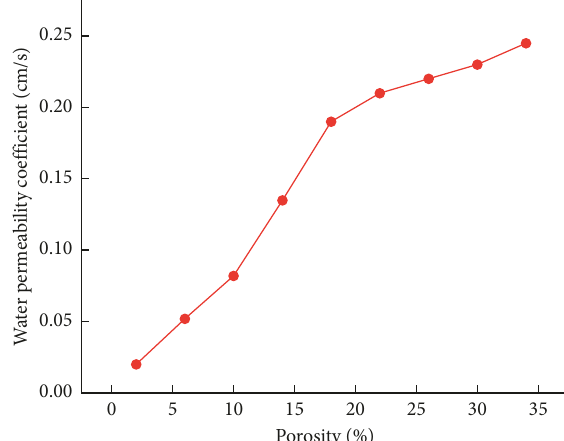
Figure 12: Relationship between porosity and permeability.